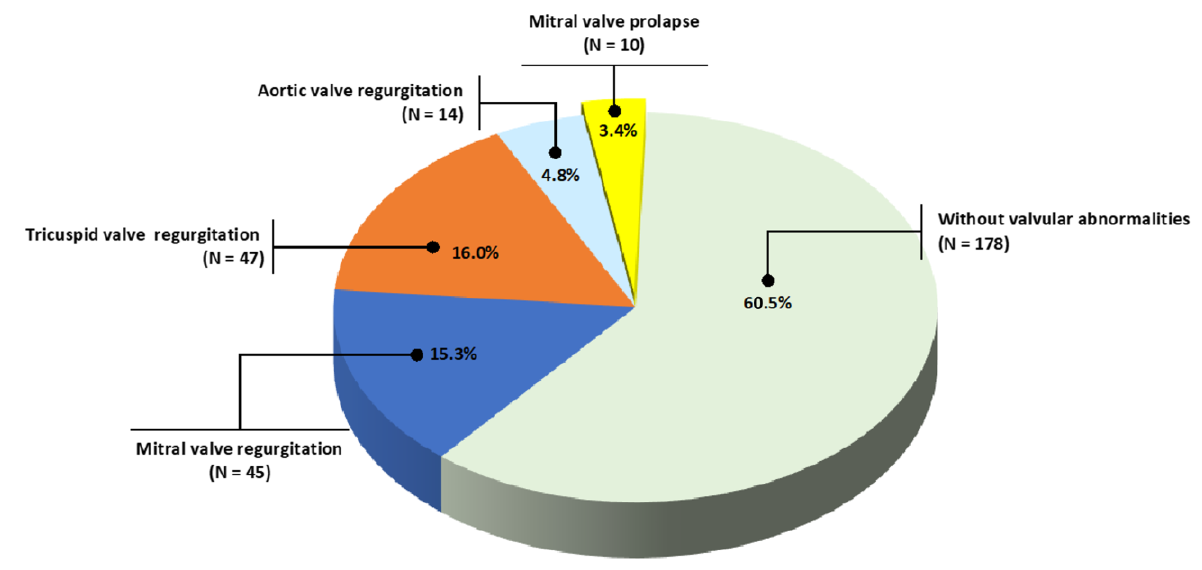
Figure 1. Valvar abnormalities.